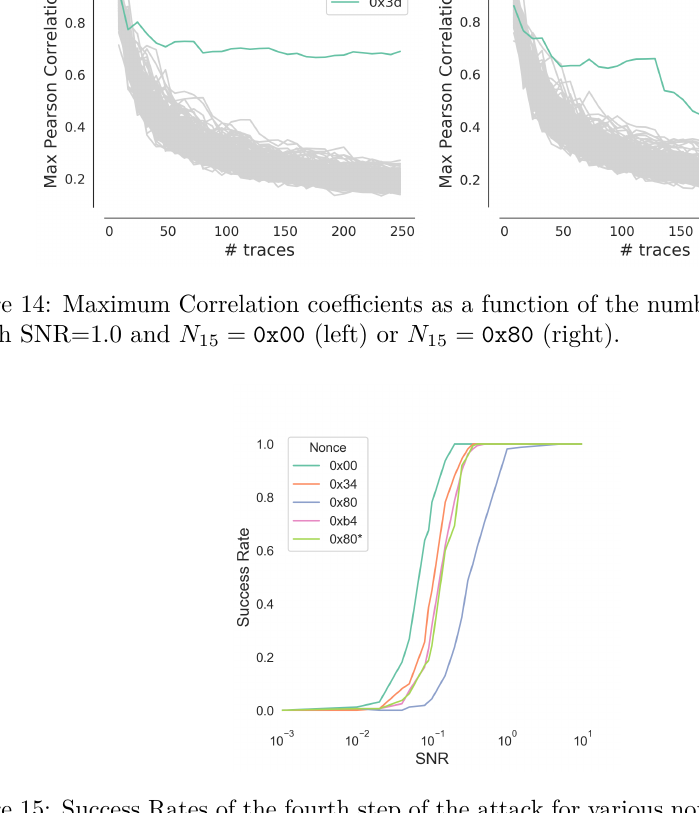
Figure 15: Success Rates of the fourth step of the attack for various nonces with 256 traces (except 0x80 ∗ with 128